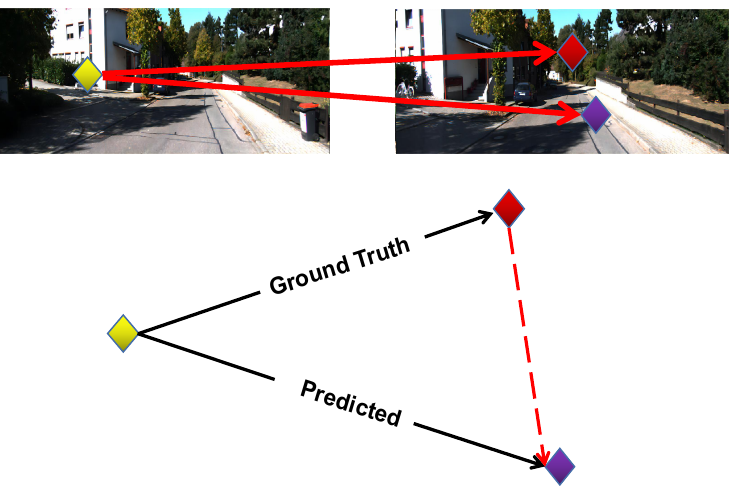
Figure 3. The yellow point has two corresponding points, that is, the red one and the purple one, generated by the traditional method and the flow network,